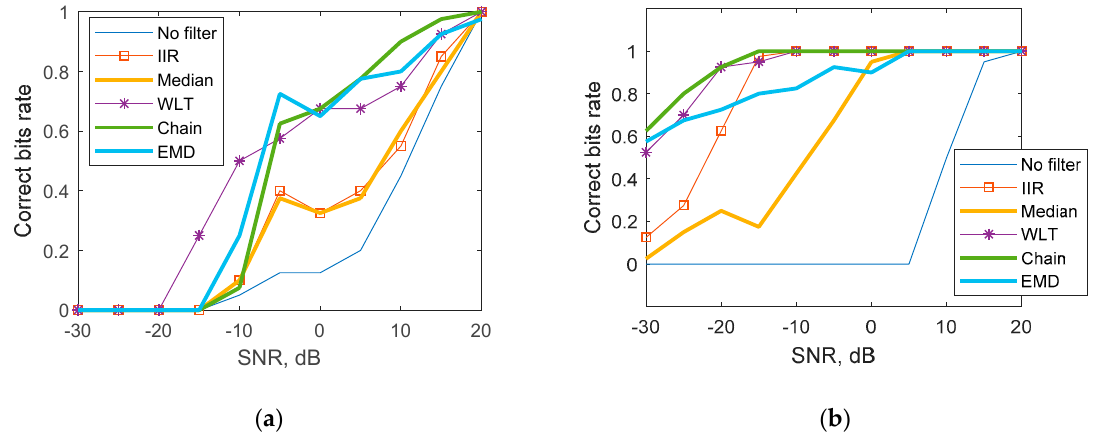
Figure 14. Ratio of correctly recognized bits according to SNR level in communication channel, noise color indicates pink ( a ) and blue ( b ), and filtration method: IIR indicates 4-th order low-pass Butterworth filter; MED indicates median filter; WLT indicates a wavelet transform filter using external phase Daubechies wavelet with 8 vanishing moments; EMD indicates the conventional EMD filter; Chain indicates the chain of driven oscillators technique.